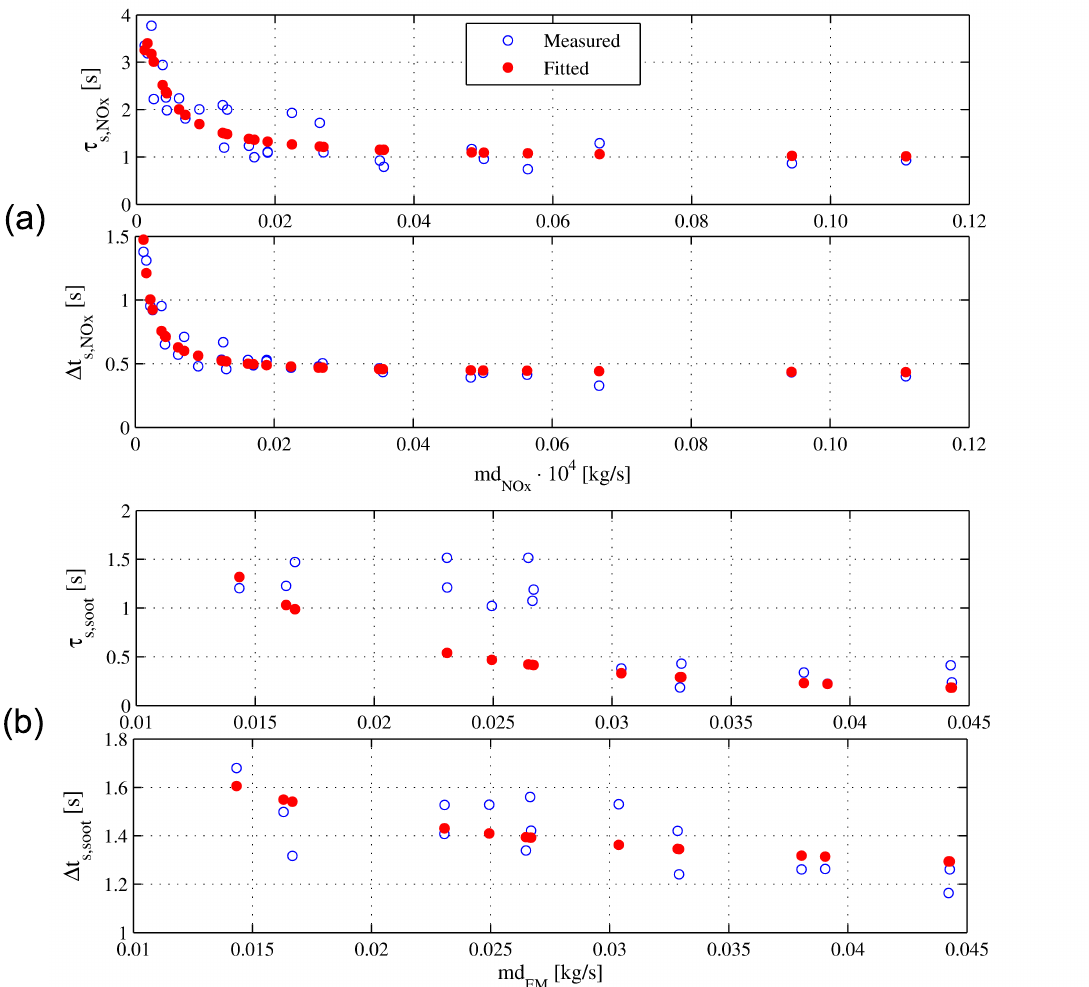
and the time delay ∆ t s,i